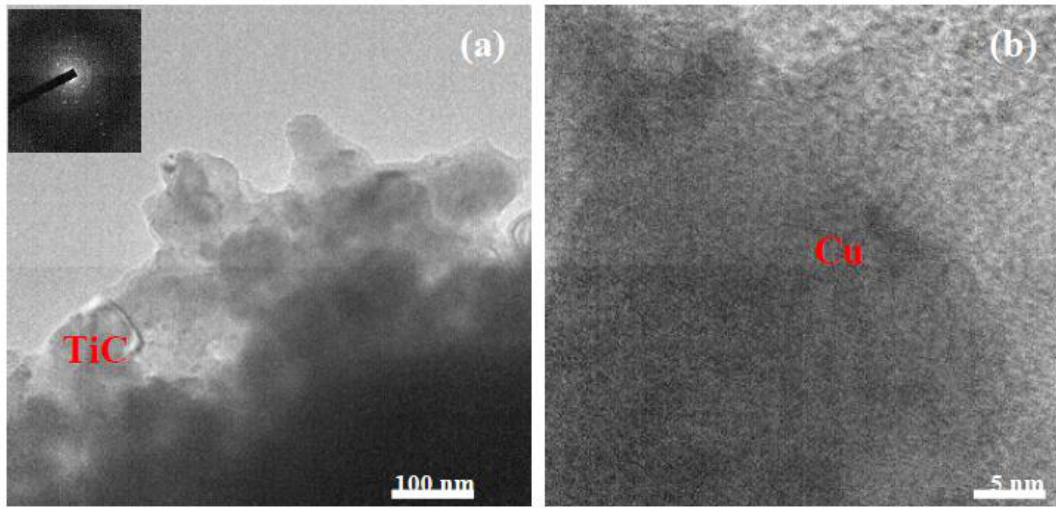
Figure 6. TEM images and selected-area diffraction pattern (SADP) of nanocomposite A of 20 vol % TiC–Cu composition sintered at 900°C: ( a ) bright-field image (inset: SADP corresponding to a TiC crystallite); ( b ) High-resolution TEM (HRTEM) of the Cu matrix.